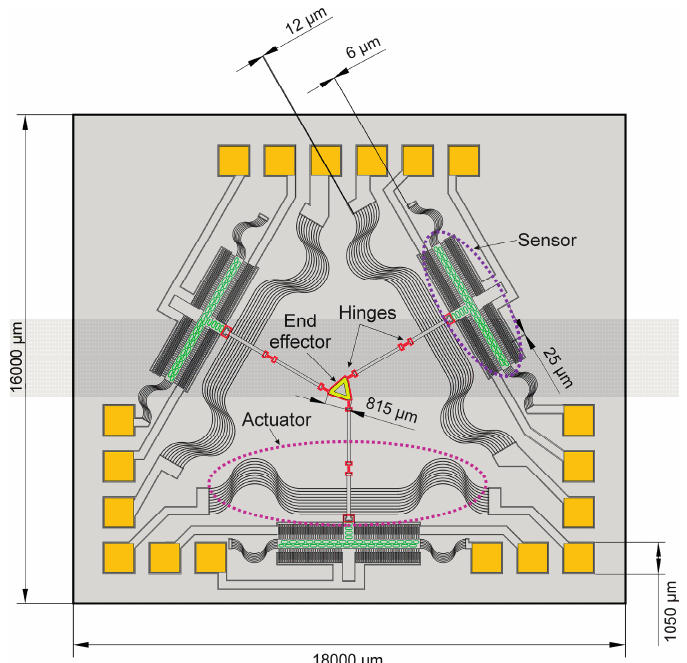
Figure 9. Microrobot concept (according to